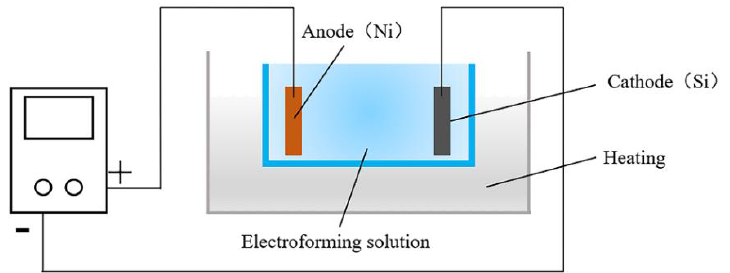
Figure 3. The V-30L micro-electroforming device.